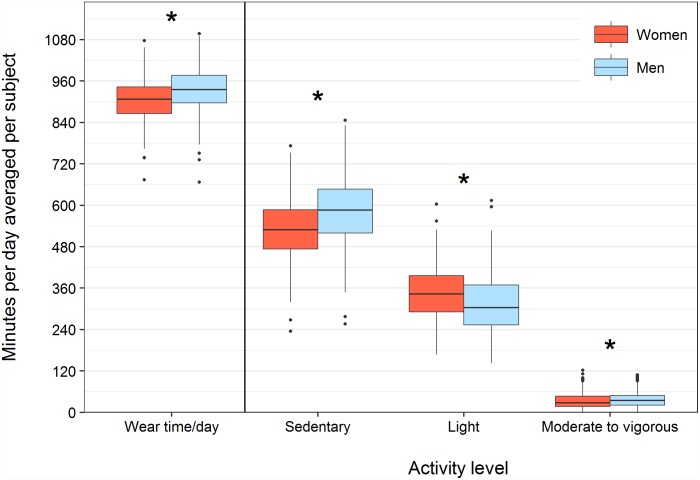
Total wear time and time spent in sedentary, light and moderate to vigorous (MVPA) activity in minutes/day averaged per subject.*p<0.05 in Wilcoxon rank-sum test (males vs. females).